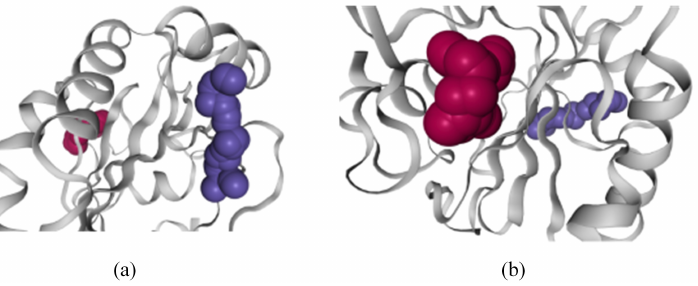
Figure 19. Three-dimensional structure of GPX4 protein molecular pocket. The purple one is an orthosteric pocket. The red one is an allosteric pocket. ( a ) Orthosteric pocket 1 in GPX4 protein molecule. ( b ) Allosteric pocket 4 in GPx4 protein